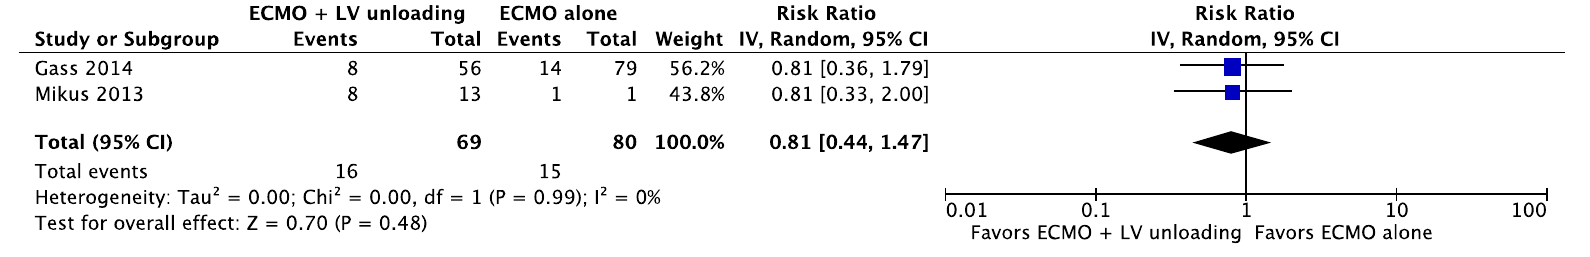
Figure A10. Revision for bleeding.